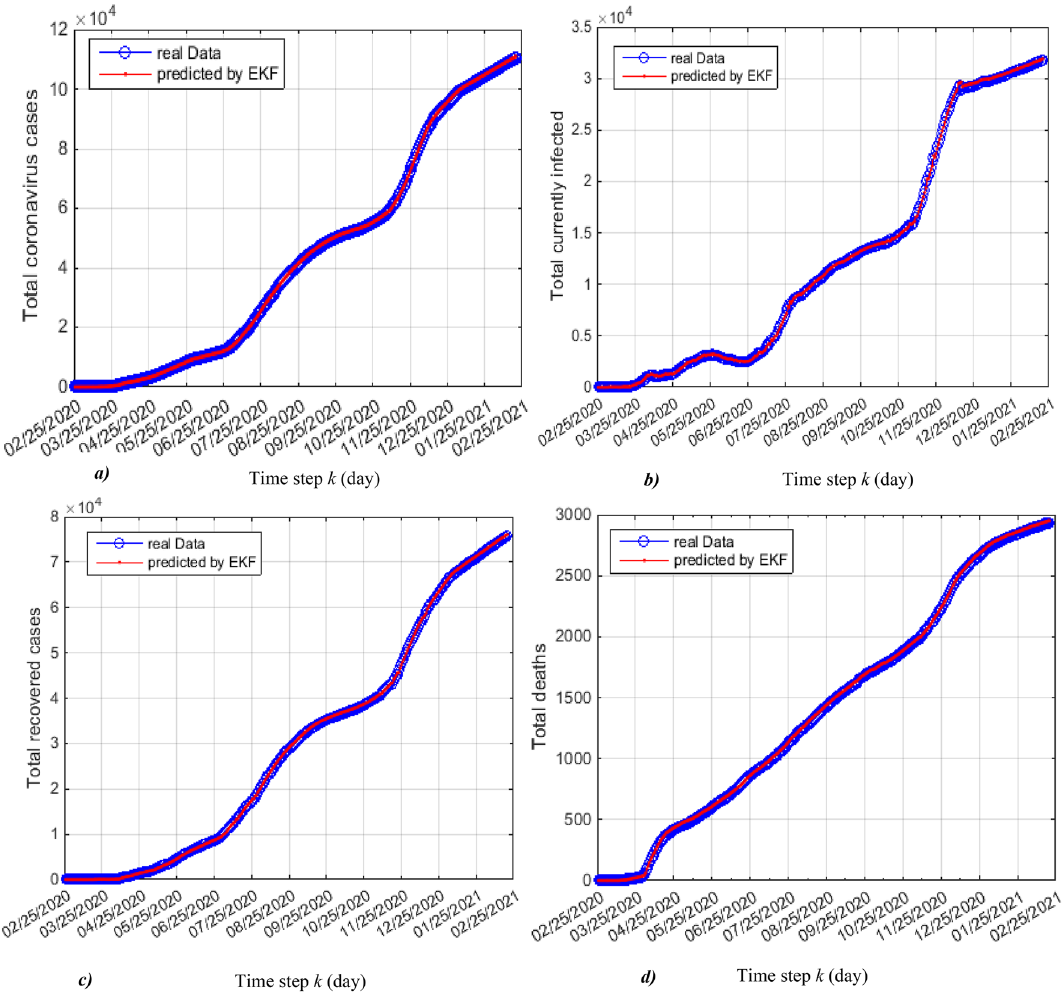
Figure 3. Real and predicted trajectories, ( a ) total coronavirus cases, ( b ) total currently infected, ( c ) total recovered cases and ( d ) total